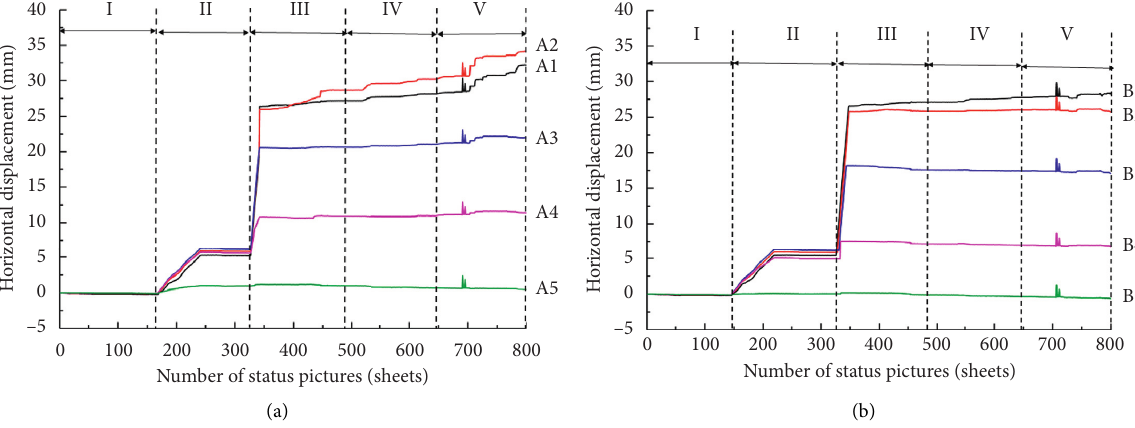
Figure 18: Horizontal displacement curves of displacement measuring points: (a) A1–A5 measuring points; (b) B1–B5 measuring points.